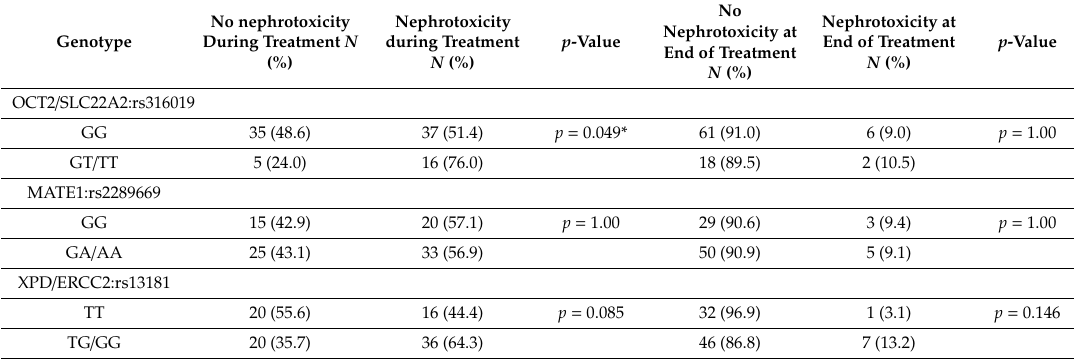
Table 4. Significance levels for genetic variants related to nephrotoxicity. * = significantly di ff erent ( p <